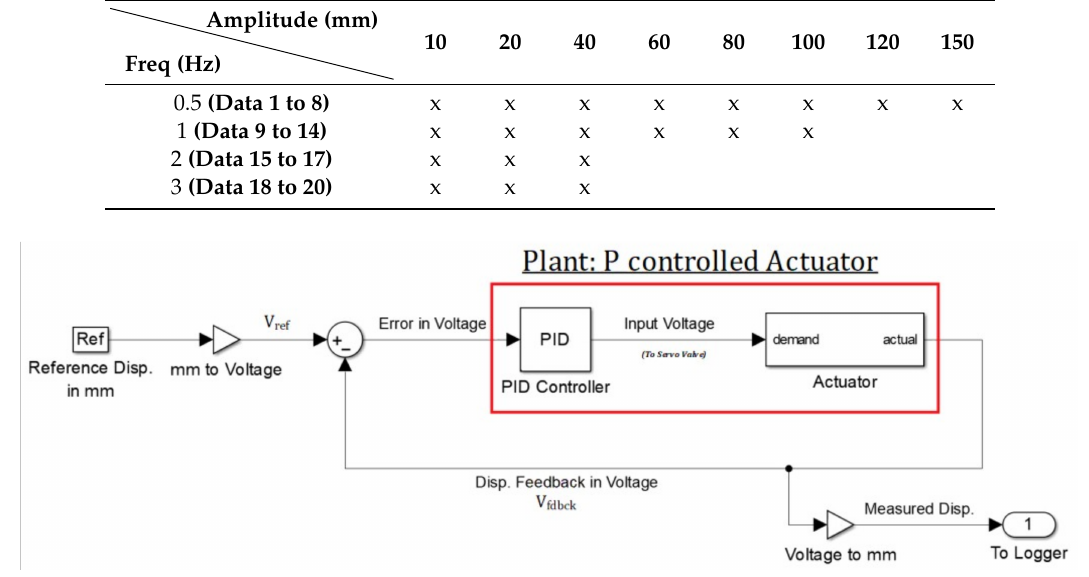
Figure 14. Schematic view of the control